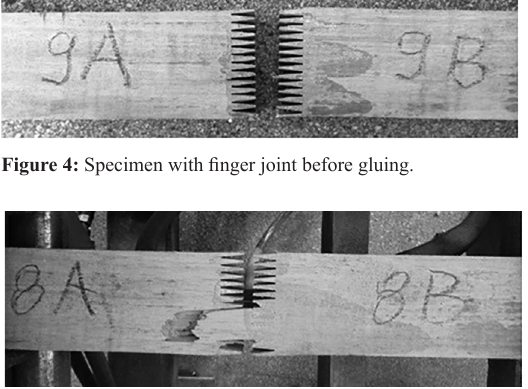
Figure 5: Specimen with finger joint right after rupture (50% in the wood and 50% in the glue).